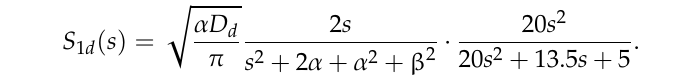
. This spectrum can be treated as an approximate